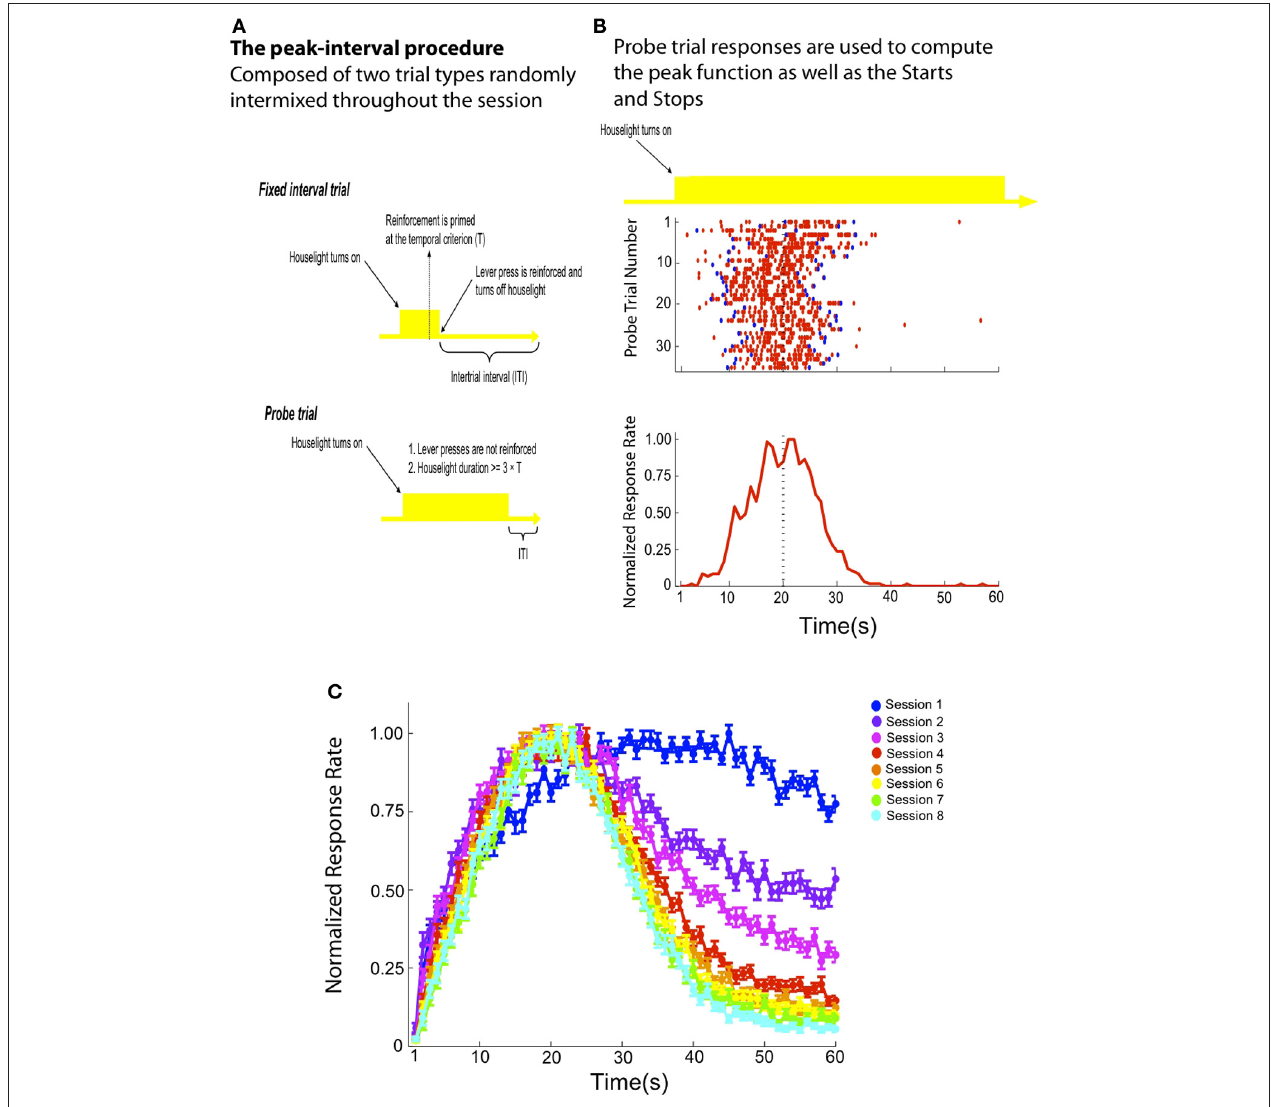
FIGURE 1 | (A) An illustration depicting the two trial types randomly intermixed throughout a standard peak-interval (PI) training session. The houselight serves as the signal being timed in this example. On FI trials, the houselight’s onset predicts the availability of reinforcement at 20s. Delivery of reward is contingent on a lever press made by the rat at or after this time, which also terminates the houselight and initiates an ITI. On probe trials, the houselight remains on for an extended period of time with a minimum of 60s and reinforcement is never delivered. (B) A representative rat that is well-trained on the PI procedure. The raster plot (top) depicts each probe trial as a row and responses (red tics) are displayed across time during the probe trial. On each trial, a response sequence contains both a “Start” and “Stop” response (blue tics), which demarcates the beginning (“Start”) and end (“Stop”) of the “high state” (see Introduction and Methods). Probe